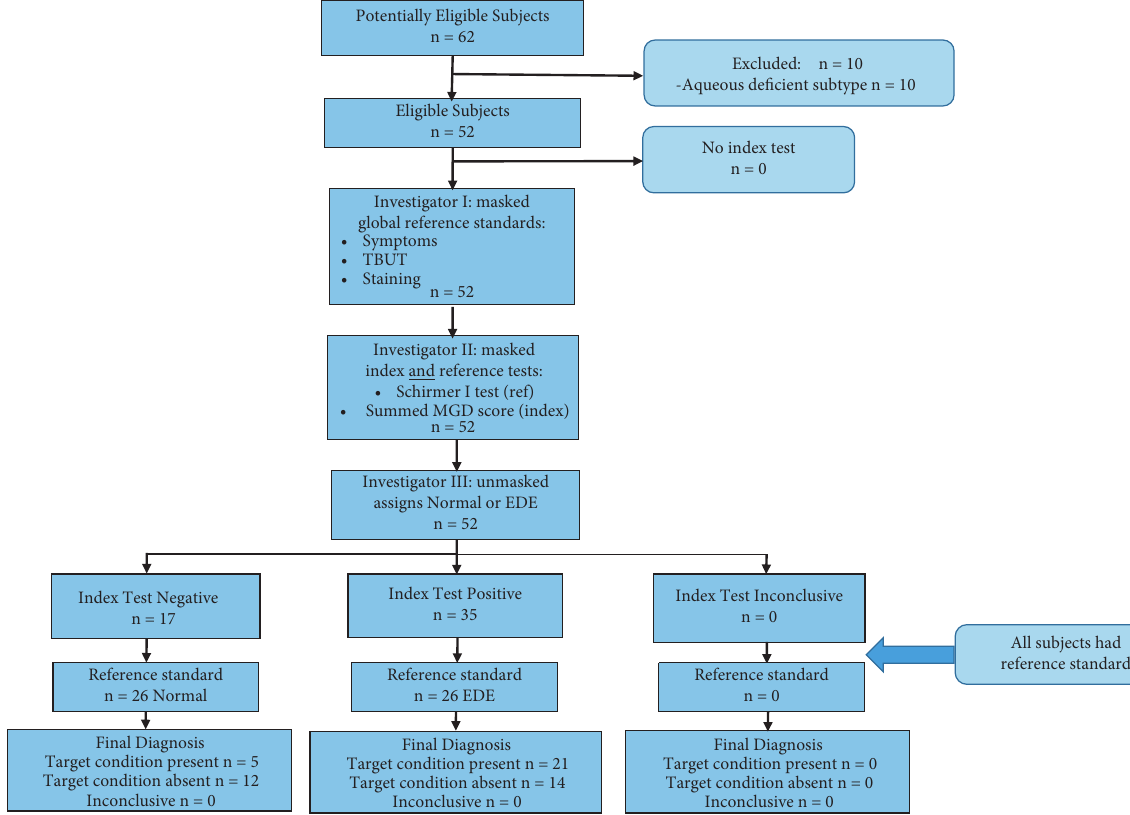
Figure 1: Participant flow diagram; STARD–2015 reporting